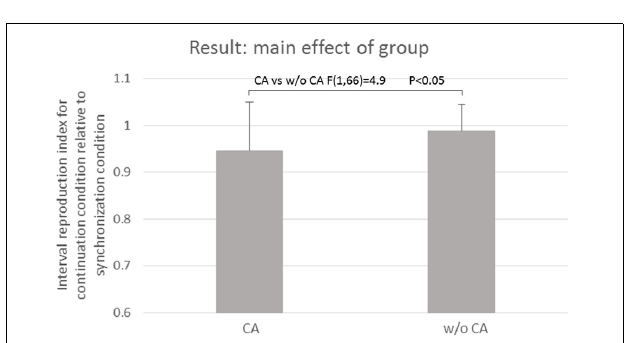
FIGURE 4 | The main effect of the group. CA, constructional apraxia; w/o CA, without constructional apraxia. Error bars indicate standard